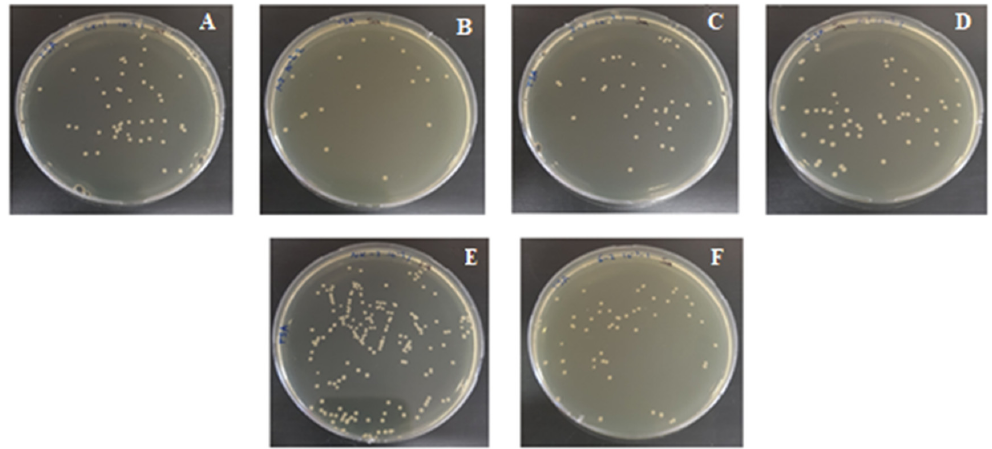
Figure 10. Antibacterial activity of Staphylococcus aureus ATCC 25923 (( A ) glass control; ( B ) CVD-1; ( C ) CVD-2; ( D ) CVD- 3; ( E ) Ni Control; ( F ) CVD-1-Ni).